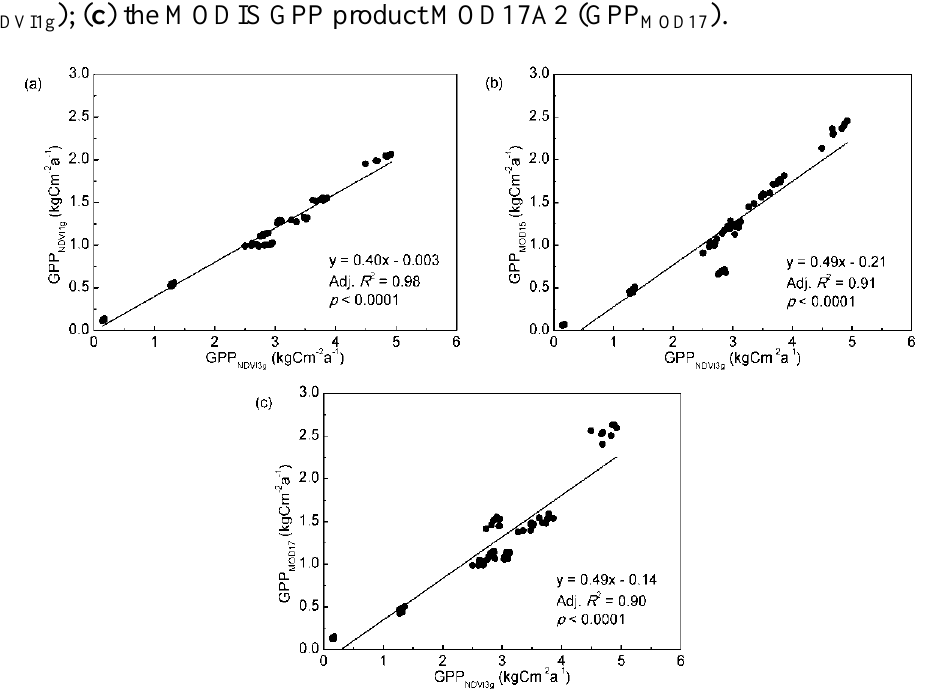
); ( b ) GIMMS NDVI1g based GPP MOD15 MOD17